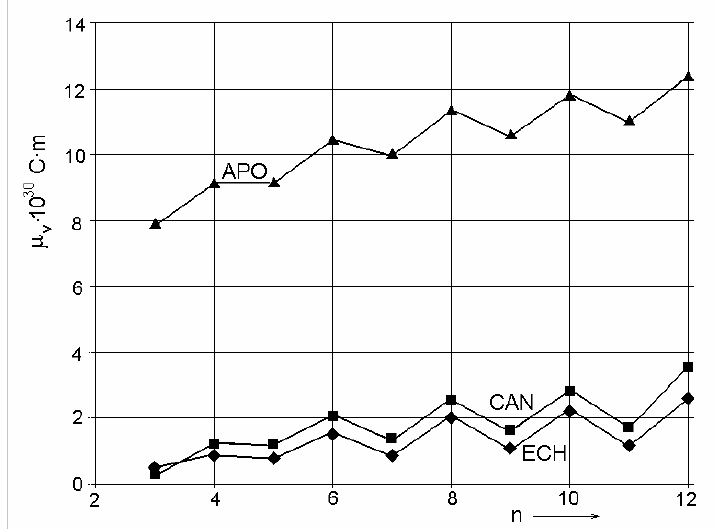
Fig. 6 Vertical component of the dipolmoment μ v versus number n of conjugated bonds (PM3